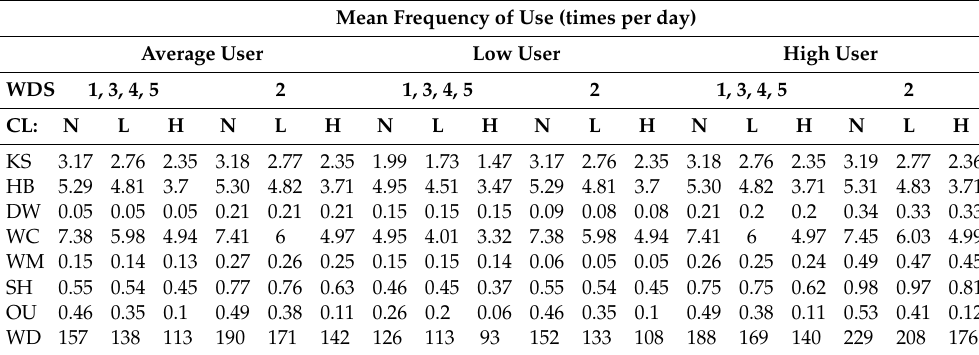
Table 3. Mean frequency of use (times per day) for all water demand